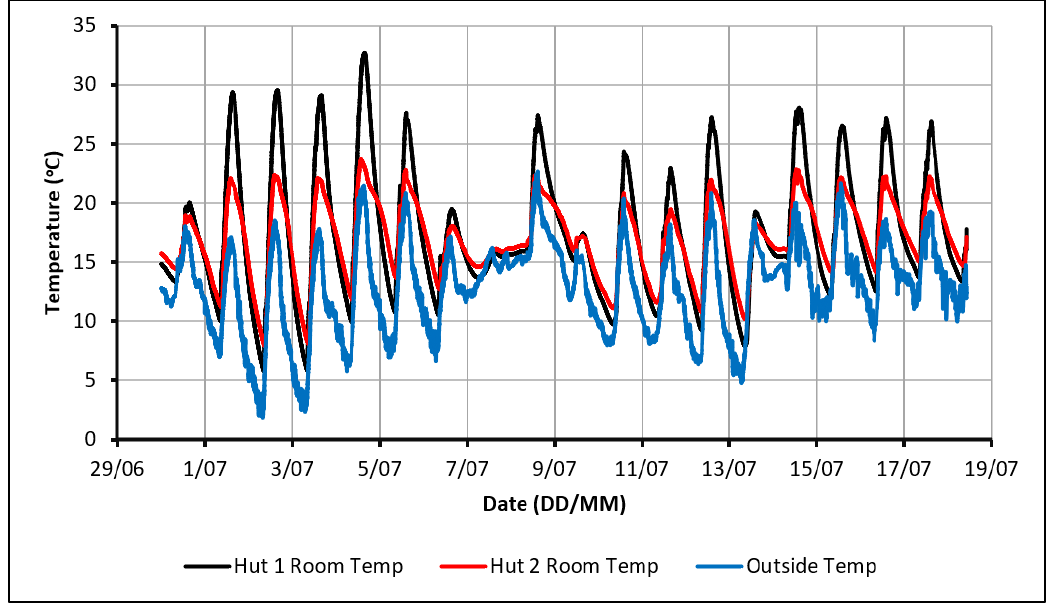
Figure 2. Temperature profiles in case of using passive solar heating only.